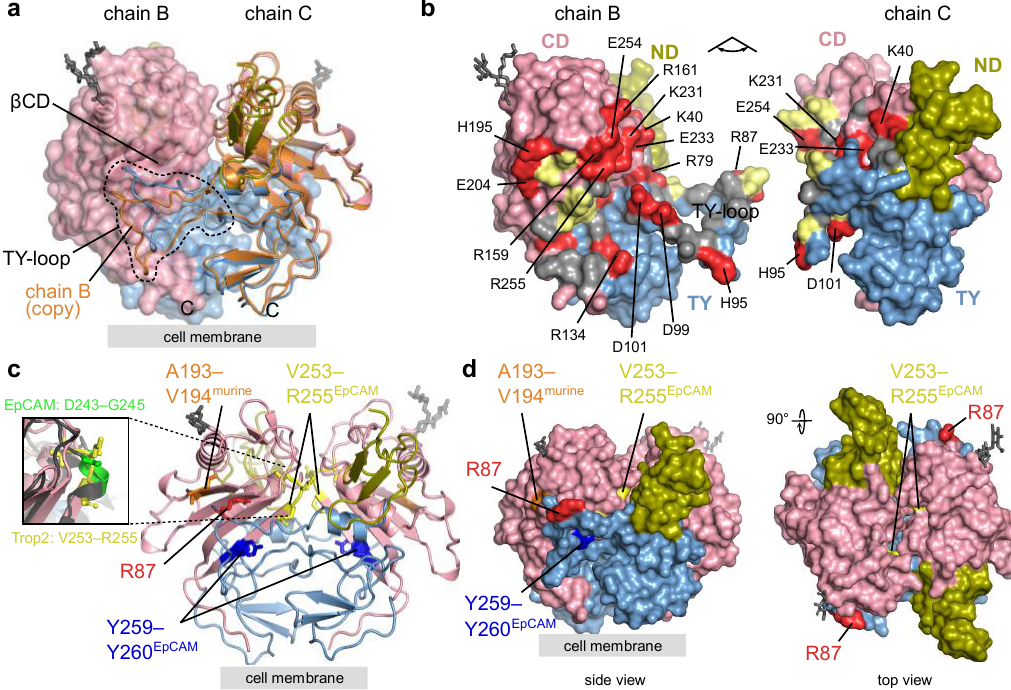
Figure 4. Trop2 ectodomain dimer—alternative TY-loop conformation, interface residues, and location of proteolytic cleavage sites. Domain color-coding is the same as in Figure 3. Carbohydrate residues are shown as grey sticks. Position of the cell membrane (proximal to the C-termini) is denoted by a grey rectangle. ( a ) Assembly composed of chains B and C corresponds to a cis-dimer (Section 2.2.2). Both chains are shown in ribbon representation and for chain B a transparent molecular surface is shown. A copy of chain B superimposed on chain C is shown in orange showing an alternative TY-loop conformation within the same dimer. ( b ) Opened Trop2 ectodomain dimer in surface representation. Charged, polar and hydrophobic residues at the dimer interface are shown in red, yellow and grey. Charged residues are labeled. ( c ) Cleavage sites mapped to Trop2 ectodomain dimer (chains B and C, as in ( a )). Matriptase and ADAM10 site is shown in red (R87), TACE site equivalent from murine Trop2 in orange (A193–V194), TACE site equivalent from human EpCAM in yellow (V253–R255), and BACE site equivalent from human EpCAM in dark blue (Y259–Y260). Zoomed-in section highlights different conformation of TACE cleavage site in EpCAM (D243–G245, bright green) and the location-equivalent site in Trop2 (V253–R255, yellow). ( d ) The same cleavage sites as in ( c ) shown on surface representation of Trop2 ectodomain dimer in two orientations.